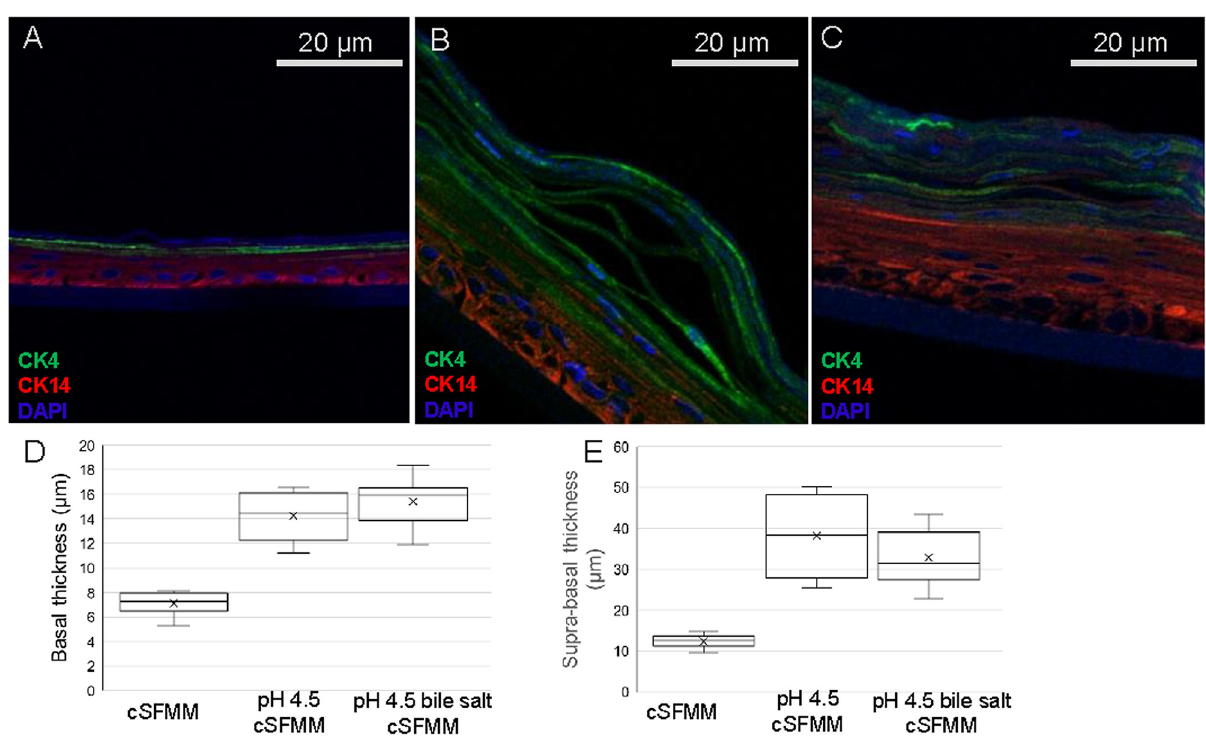
Fig 3. Immunofluorescence for basal and supra-basal differentiation markers and basal/supra-basal thickness of the squamous epithelium in 3D OTC-ALI established with conditioned media from untreated, pH 4.5, and pH 4.5 bile salt treated HEMFs. Basal (red, CK 14) and supra-basal (green, CK 4) immunofluorescent staining shown in panels A-C for the epithelium in 3D OTC established with conditioned media from untreated (A), pH 4.5 treated (B), and pH 4.5 bile salt treated (C) HEMFs. Overlap between basal (red, CK 14) and supra-basal (green, CK 14) differentiation markers is visible in the epithelium established with conditioned media from pH 4.5 (B) treated HEMFs. Representative images of three independent, reproducible experiments are shown. (D and E) Box and whisker plot of data from three independent experiments is shown (minimum, maximum, lower and upper quartile, and median are shown in the box and whisker plot). Mean values are indicated by X. (D) Quantification of basal epithelial thickness as defined by CK14 immunostaining shows an increase in mean basal thickness of the epithelium established with conditioned media from pH 4.5 and pH 4.5 bile salt treated HEMFs (mean values: 7.1 μ m vs. 14.2 μ m and 15.4 μ m, p < 0.05; ranges of CK14 + cell layer thickness in cSFMM, pH 4.5 cSFMM, and pH 4.5 bile salt samples are 6.6–8.0 μ m; 11.2–16.5 μ m; and 11.8–18.4 μ m, respectively) (E) Quantification of supra-basal thickness as defined by CK4 immunostaining shows an increase in mean supra-basal thickness of the epithelium established with conditioned media from pH 4.5 and pH 4.5 bile salt treated HEMFs (mean values: 12.3 μ m vs 38.1 μ m and 32.8 μ m, p < 0.05; ranges of CK4 + cell layer thickness in cSFMM, pH 4.5 cSFMM, and pH 4.5 bile salt samples are 9.5–13.8 μ m; 25.5–50.1 μ m; and 22.7–43.5 μ